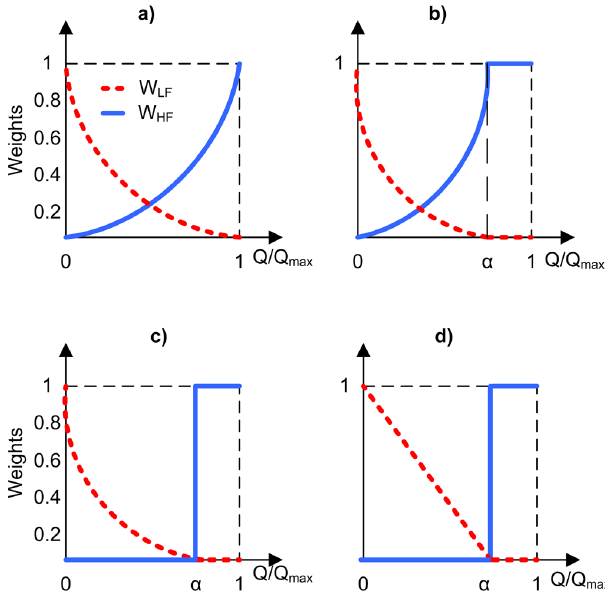
Fig. 1. (a) WStype I, weighting scheme for objective functions stud- ied in Fenicia et al. (2007). (b) WStype II, (c) WStype III, and (d) WStype IV; additionally, these three weighting schemes were at- tempted in the latest experiments.